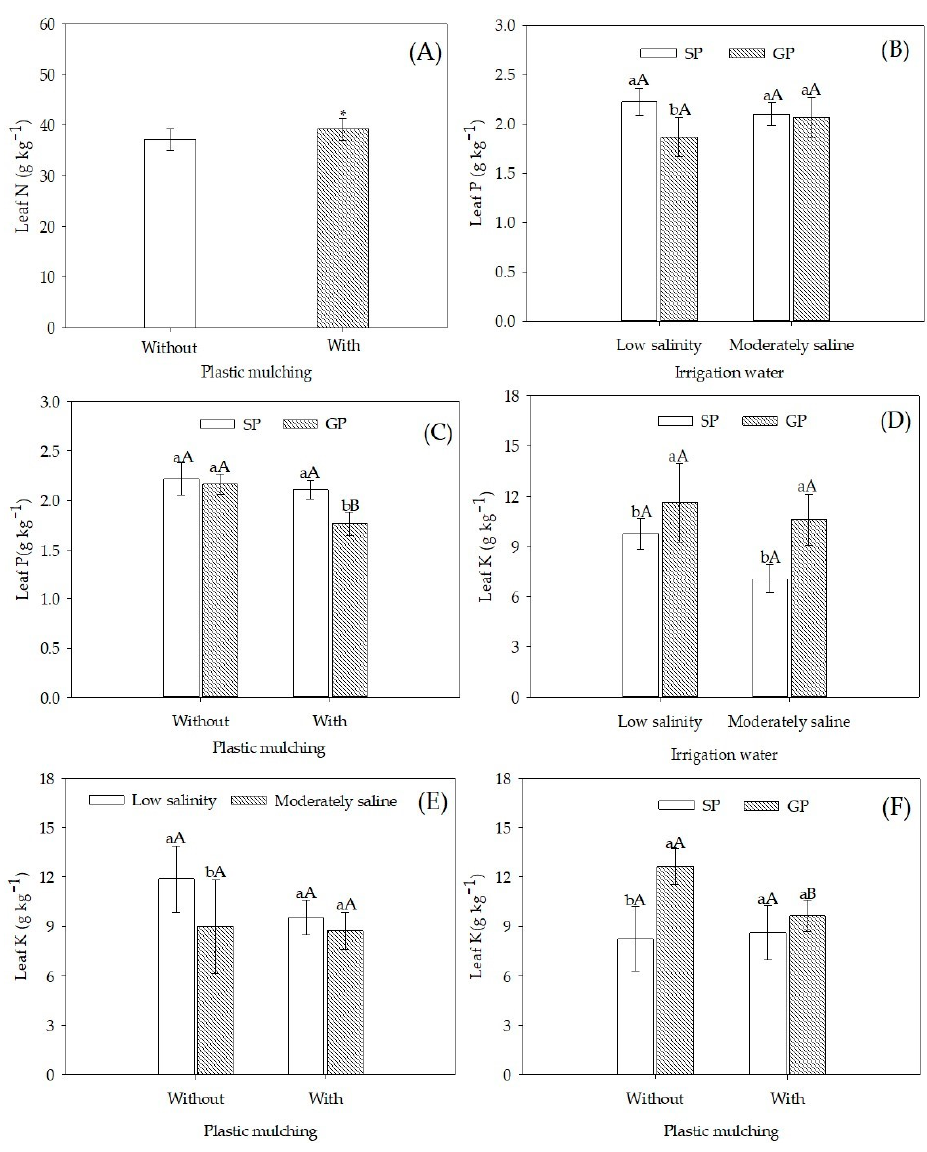
Figure 1. Concentration of macronutrients in leaves of sour passion fruit by seed-propagated and grafted propagated irrigated with low salinity and moderately saline waters with and without plastic mulching. ( A ) N concentration of sour passion fruit in mulched soil; ( B ) P concentration of seed-propagated (SP) and grafted propagated (GP) on P. cincinnata irrigated with low and moderately saline water; ( C ) K concentration of seed-propagated (SP) and grafted propagated (GP) on P. cincinnata in soil without and with plastic mulching; ( D ) K concentration of seed-propagated (SP) and grafted propagated (GP) on P. cincinnata irrigated with low salinity and moderately saline water; ( E ) K concentration in leaves of sour passion fruit irrigated with low salinity and moderately saline water and in soil without and with mulching plastic; ( F ) K concentration of seed-propagated (SP) and grafted propagated (GP) on P. cincinnata fruit in soil without and with mulching plastic. Vertical bars represent the standard error of the mean ( n = 4). Bars with an asterisk (*) differ from each other for soil with and without plastic mulching by the F-test ( p > 0.05) ( A ). Bars with the same lower-case letter are similar for soil with and without plastic mulching ( C , E , F ) or for low salinity and moderately saline irrigation water ( B , D ) by the F-test ( p > 0.05). Bars with the same uppercase letter are similar for seed propagation and grafting ( B – D , F ) or low salinity and moderately saline irrigation water ( E ) by the F-test ( p >